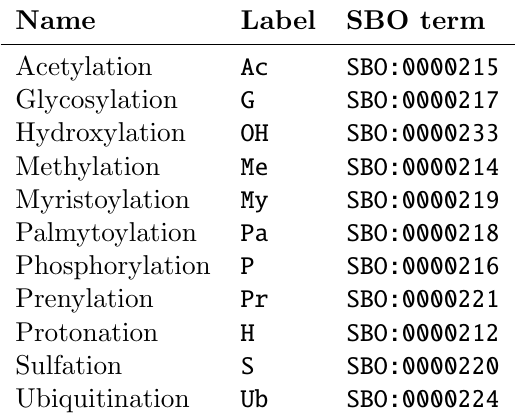
Table 2.4: A sample of values from the covalent modifications vocabulary (Section 2.2.3).